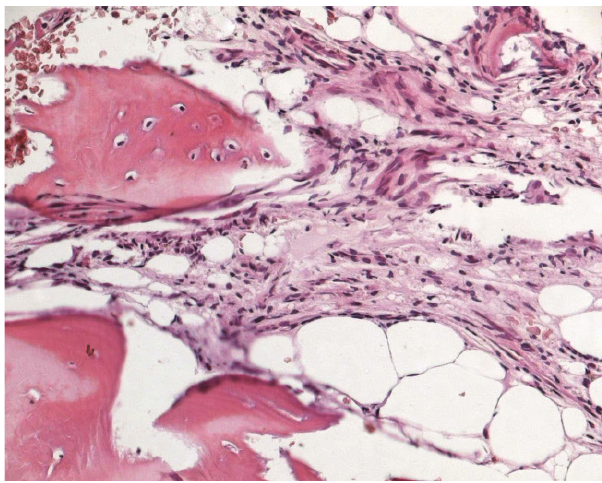
Figure 7 - Histological appearance of the material collected from the percutaneous biopsy, processed in paraffin for staining with hematoxylin and eosin. Observe the osteoid osteoma niche and the eosinophilic areas of newly formed bone without a trabecular